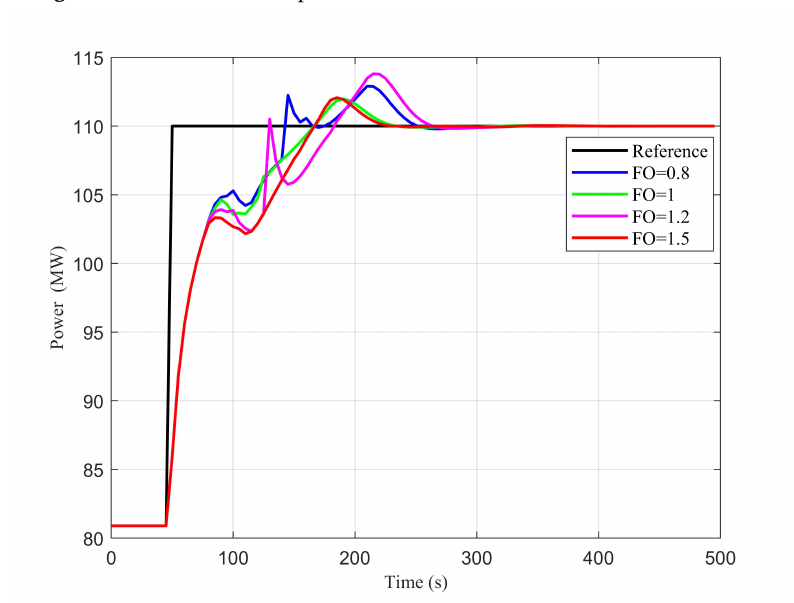
Figure 4. The required power for turbine with different fractional